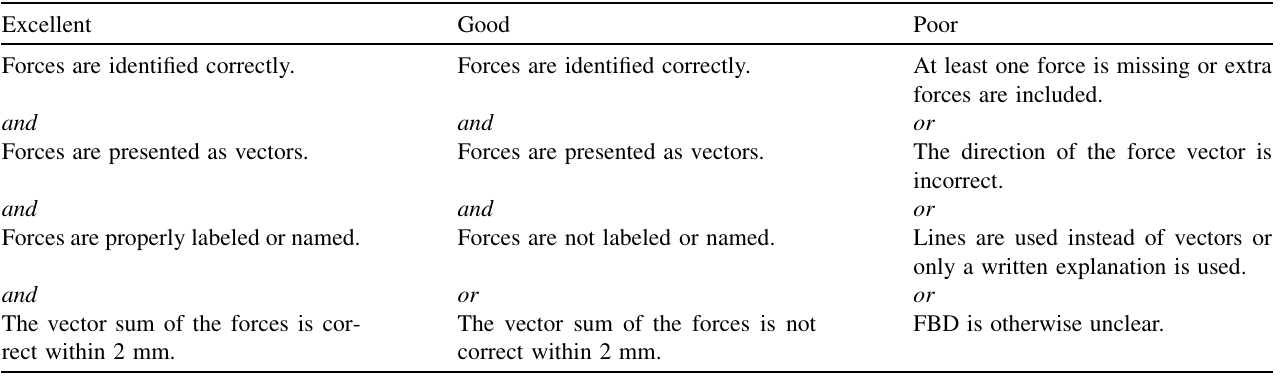
TABLE IV. The classification of the quality of students’ free-body